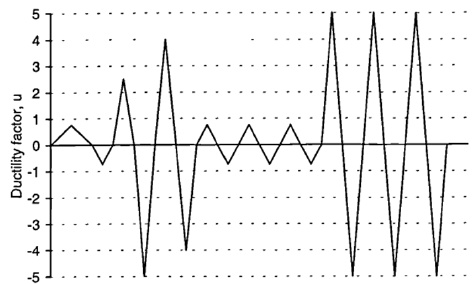
Figure 1. Loading protocol used by Hanson and Connor [4].